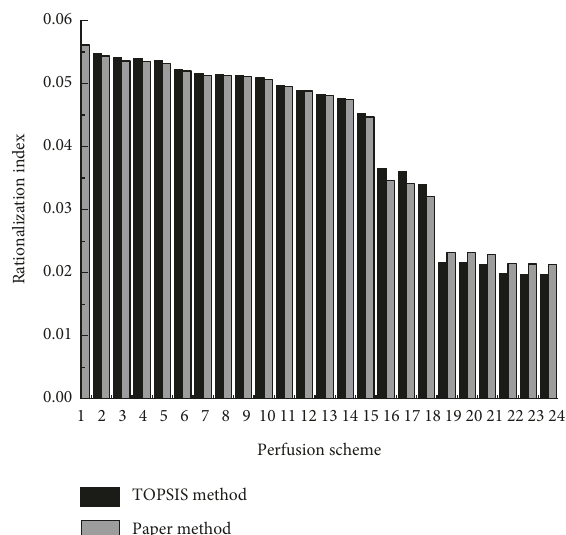
Figure 4: Rationalization indexes in different pouring